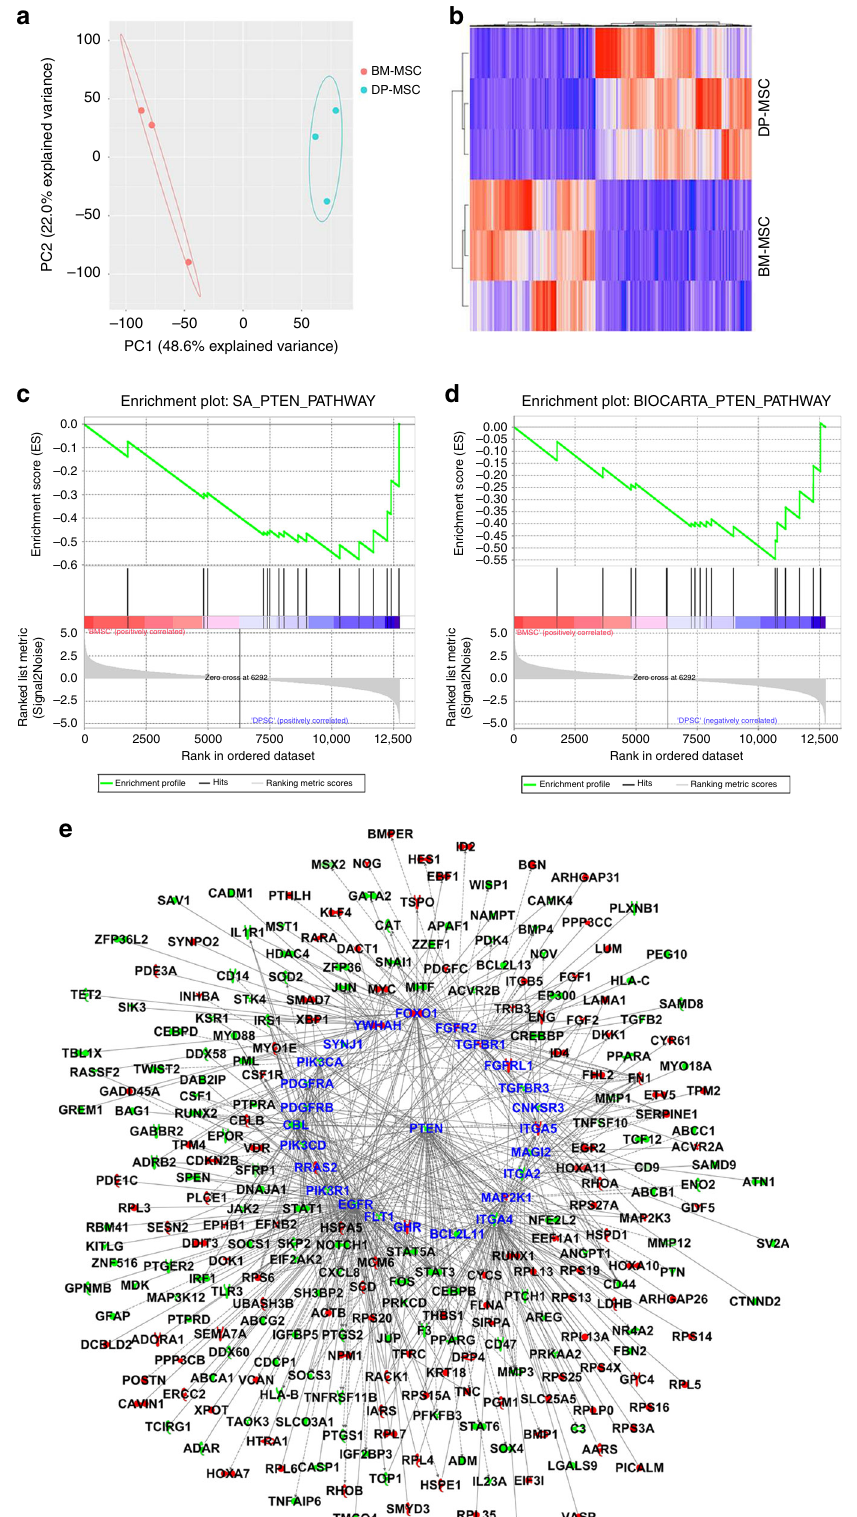
Fig. 2 PTEN pathway was signi fi cantly upregulated in DP-MSCs. a PCA analysis of the global genes. b Heat map and hierarchical clustering analysis of differentially expressed genes. Both c SA_PTEN_PATHWAY (enrichment score = − 0.58, p -value = 0.013) and d BIOCARTA_PTEN_PATHWAY (enrichment score = − 0.55, p - value = 0.037) are down-regulated in BM-MSCs compared to DP-MSCs as validated by GSEA. e PTEN pathway plays a key upstream regulator orchestrating differentiation of bone cells and adipocytes, and bone marrow carcinogenesis. All genes in this network are differentially expressed between BM-MSCs and DP- MSCs ( p -value with FDR correction<0.05). Red nodes are genes up-regulated in BM-MSCs compared to DP-MSCs, and green nodes are genes down-regulated in BM-MSCs compared to DP-MSCs. 25 PTEN signaling genes are highlighted with red edges and increased word